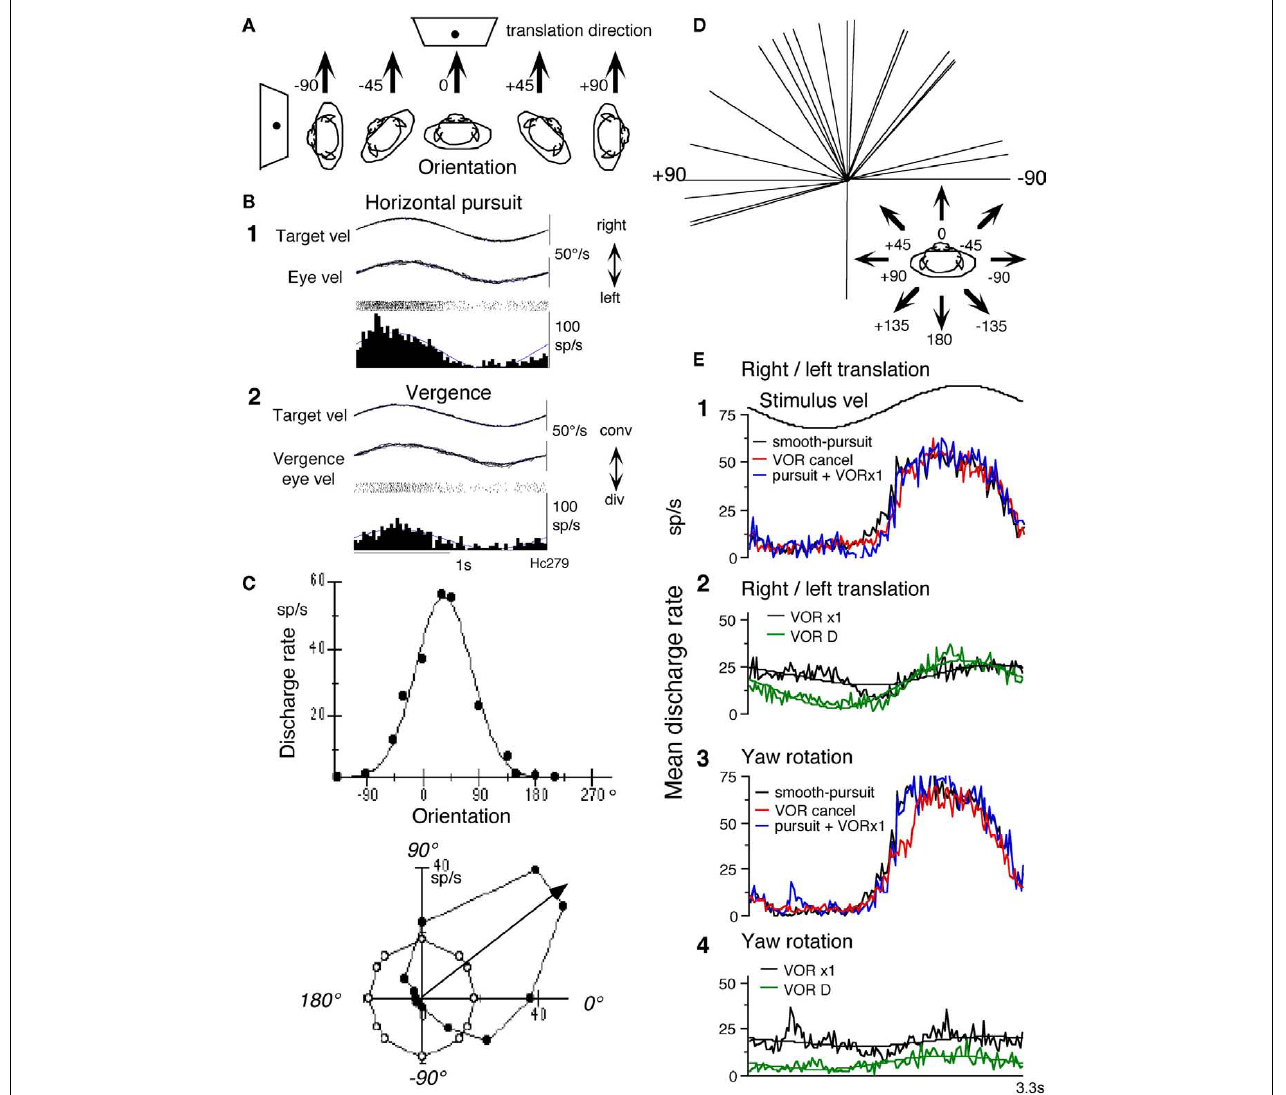
mean response of seven neurons. (E3,E4) Show mean response of six of the seven neurons, during smooth-pursuit [ (E1,E2) , black], right/left translational VOR (tVOR) cancelation [ (E1) , red] and tVOR × 1 [ (E2) , black], right/left translation in complete darkness without a target [ (E2) ,VOR D, green], rotationalVOR cancelation [ (E3) , red] andVOR × 1 [ (E4) , black], and yaw rotation in complete darkness without a target [ (E4) ,VOR D, green]. Predicted modulation during translationalVOR cancelation is shown in (E1) in blue by adding discharge during smooth-pursuit and tVOR × 1. Predicted modulation during rotationalVOR cancelation is shown in (E3) in blue by adding discharge during smooth-pursuit and rotationalVOR × 1. Mean resting discharge rate during fixation of a stationary target without vestibular stimulation was subtracted from the adding discharge in (E1,E3) . In (E2,E4) , fit sine function is shown for each discharge. Reproduced from Akao et al. (2009) with